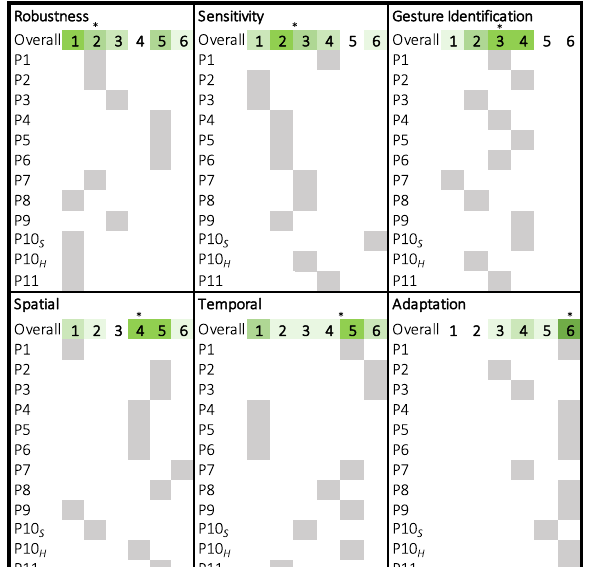
Figure 7: The participant ’ s individual responses for the requirement - ranking task. A ranking of 1 indicates the most important require - ment, and 6 indicates the least important. A summary of each re - quirement ranking is also displayed at the top of each panel using a green opacity overlay – the darkness of a number ’ s green back - ground indicates the number of participants who selected that rank for that requirement. White means that no participants chose that ranking. The asterisk above each overall summary indicates that requirement ’ s median ranking. Participant 10 completed two dif - ferent versions of the ranking – one for using the robot in a school setting ( P10 S ) and the second for using it in a home ( P10 H )